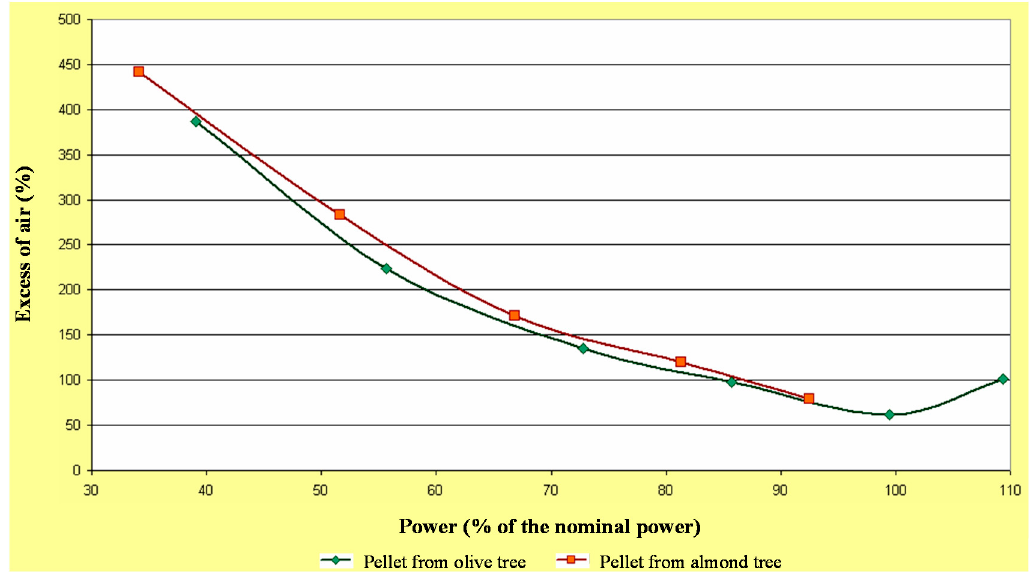
Figure 6. Evolution of excess of air depending on the load for pellets from olive and almond trees.